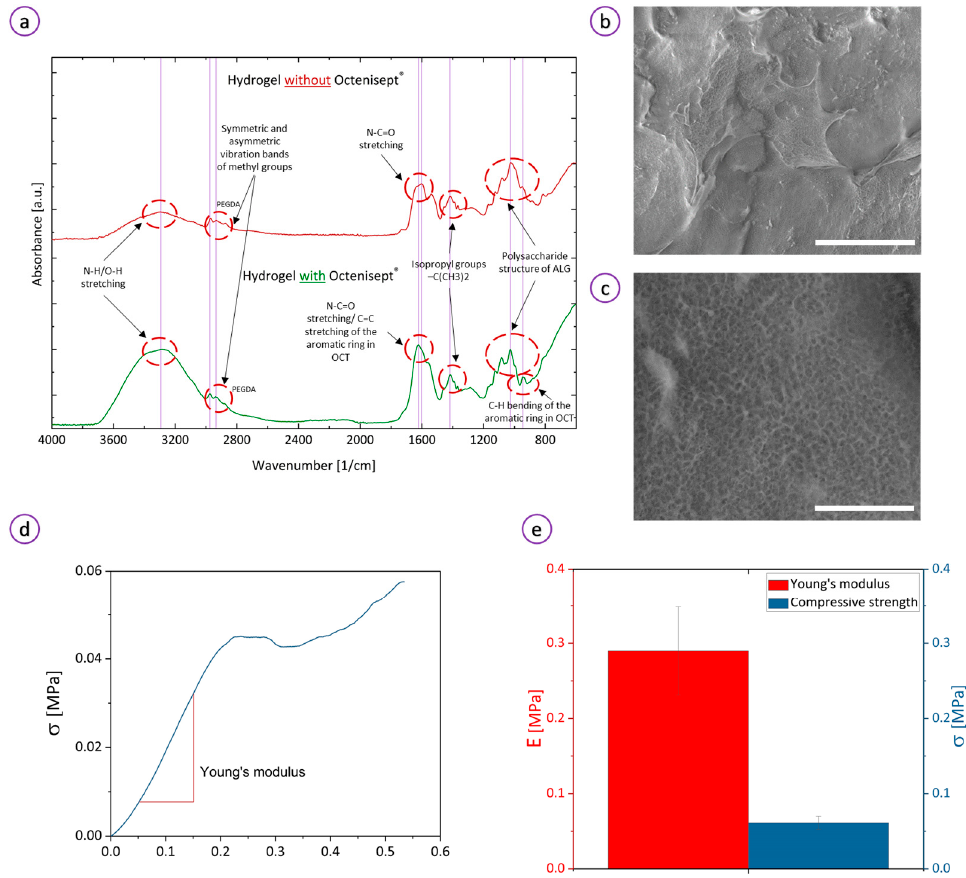
Figure 3. Hydrogel characterization: ( a ) ATR-FTIR spectrum of the 3D-printed sample with (top) and without (bottom) OCT; ( b , c ) cryo-SEM images of the cross-sectional microstructure of the specimens. Bars correspond to 40 and 5µm, respectively; ( d ) stress–strain curve of the hydrogel; ( e ) Young’s modulus and compression strength of the material.